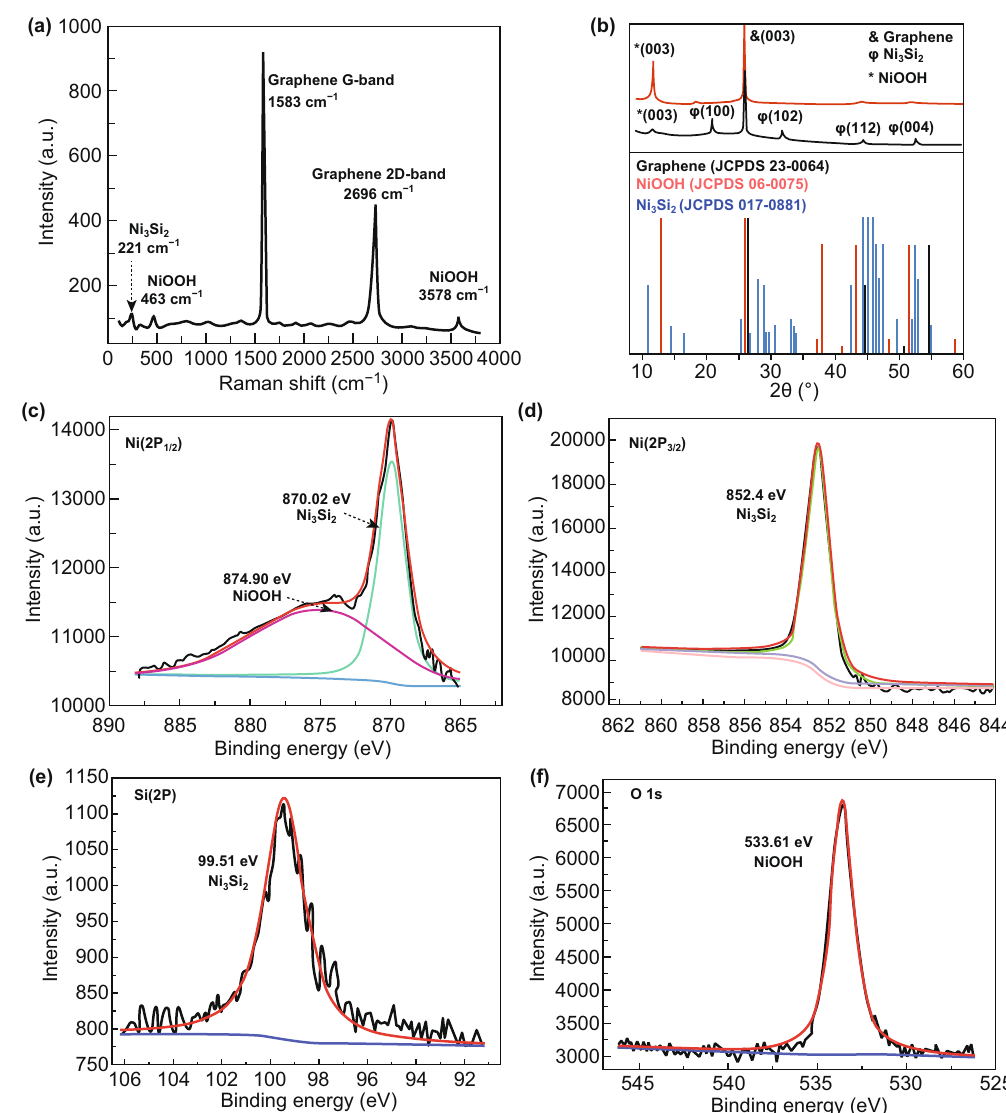
Fig. 5 a Raman spectra of Ni 3 Si 2 /NiOOH/graphene. b XRD patterns of NiOOH/graphene and Ni 3 Si 2 /NiOOH/graphene. c–f XPS survey spectra of Ni 3 Si 2 /NiOOH/graphene electrodes (Ni 2 p , Si 2 p , and O 1 s